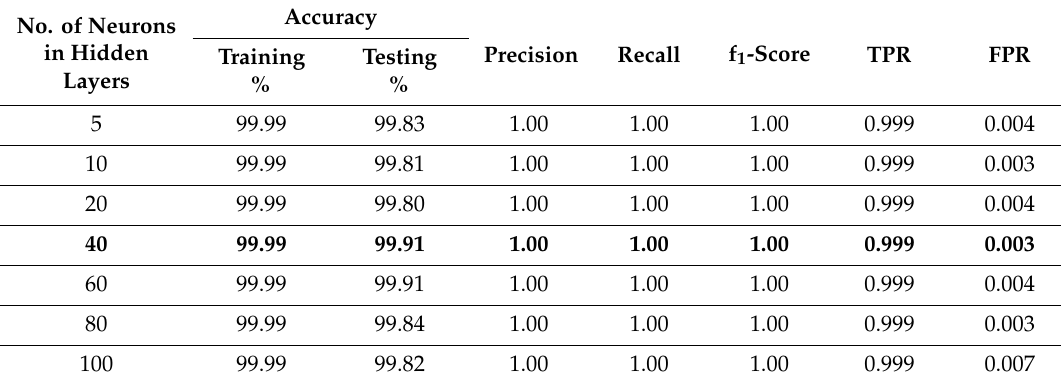
Table 8. Binary classification performance results using 99 features.